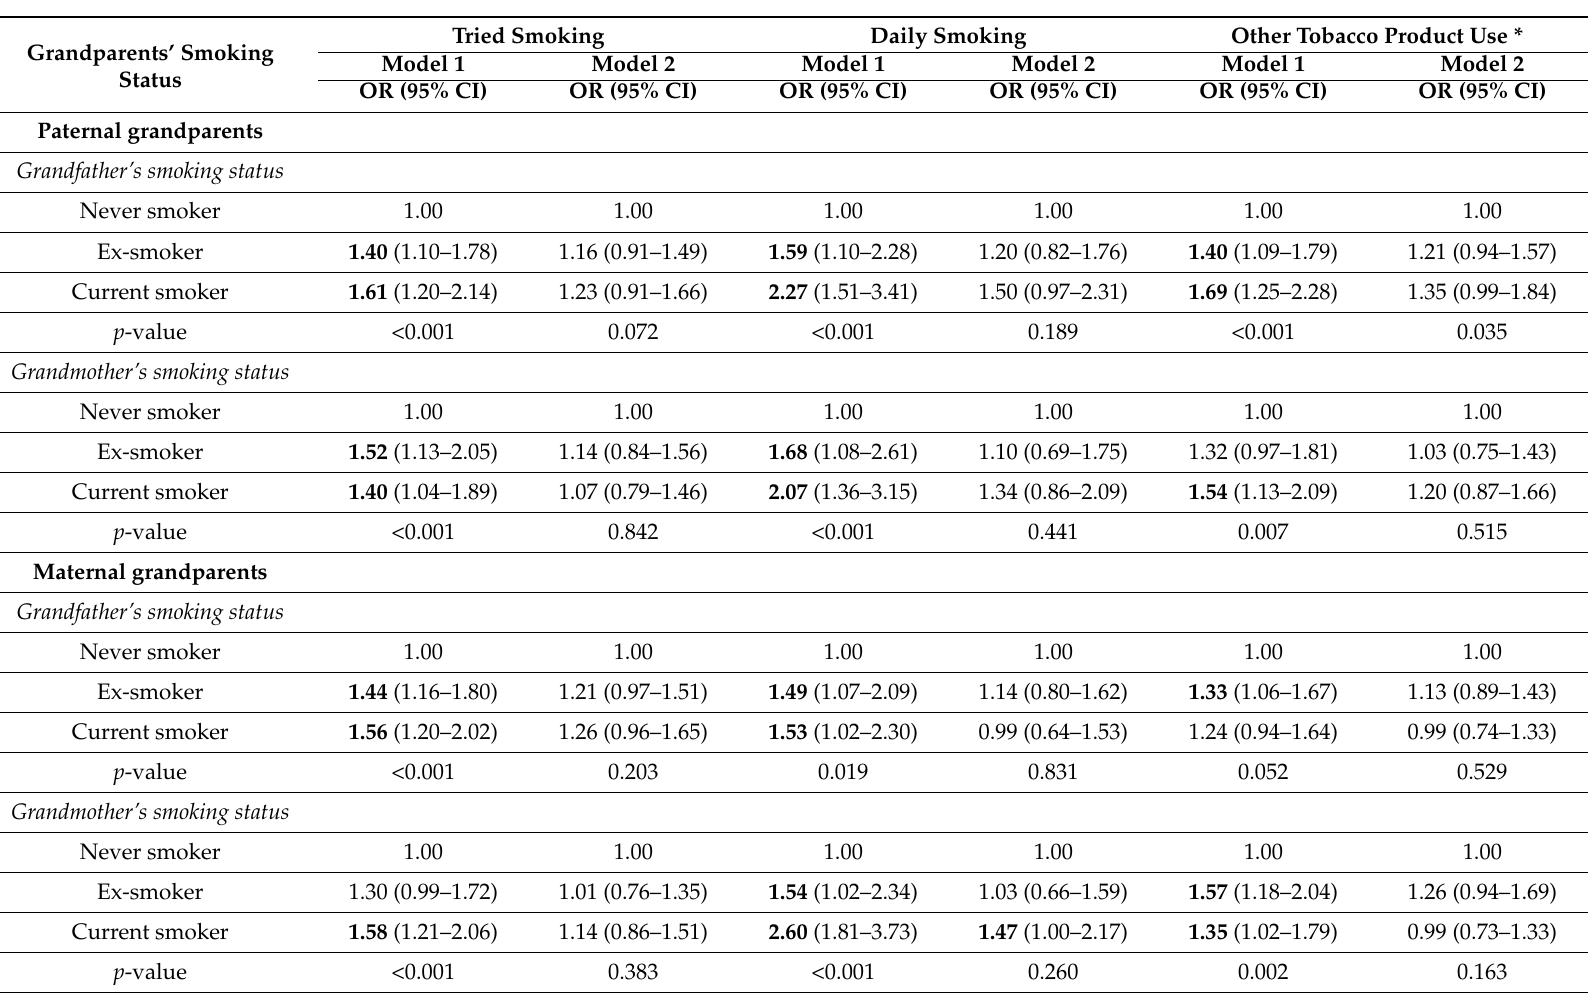
Table 3. Adjusted ORs and 95% CIs for children’s smoking experimentation, daily smoking and other tobacco product use * by grandparents’ smoking status in two models †